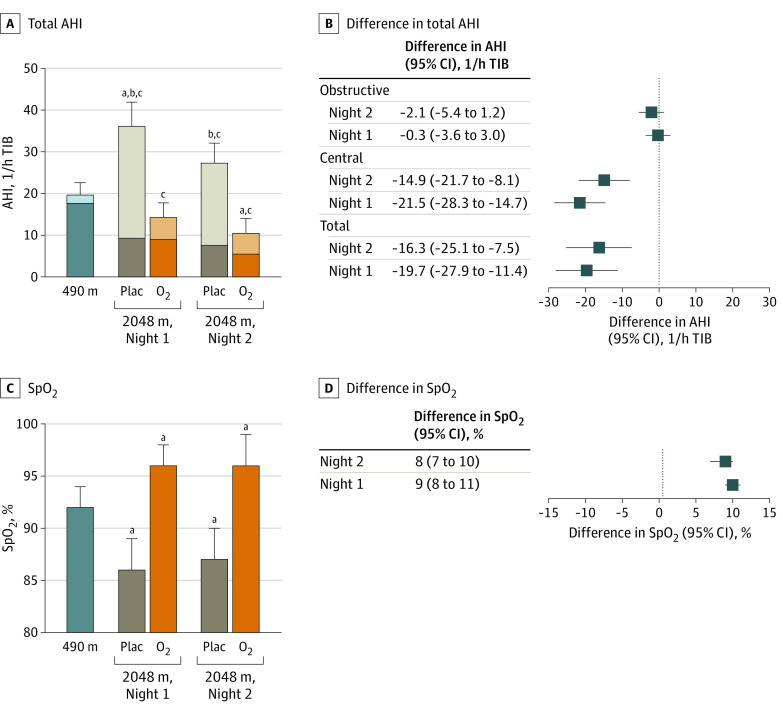
Effect of Altitude and Nocturnal Oxygen Therapy on the Apnea-Hypopnea Index (AHI) and Mean Arterial Oxygen Saturation (SpO2) in Intention-to-Treat AnalysisCentral proportions of AHI are indicted by the lighter shades; darker shades, the obstructive proportion of the apnea-hypopnea index; whiskers, 95% CI; O2, oxygen; plac, placebo; and TIB, time in bed.aP < .05 compared with 490 m in total AHI or mean SpO2.bP < .05 compared with 490 m in central AHI.cP < .05 compared with 490 m in obstructive AHI.